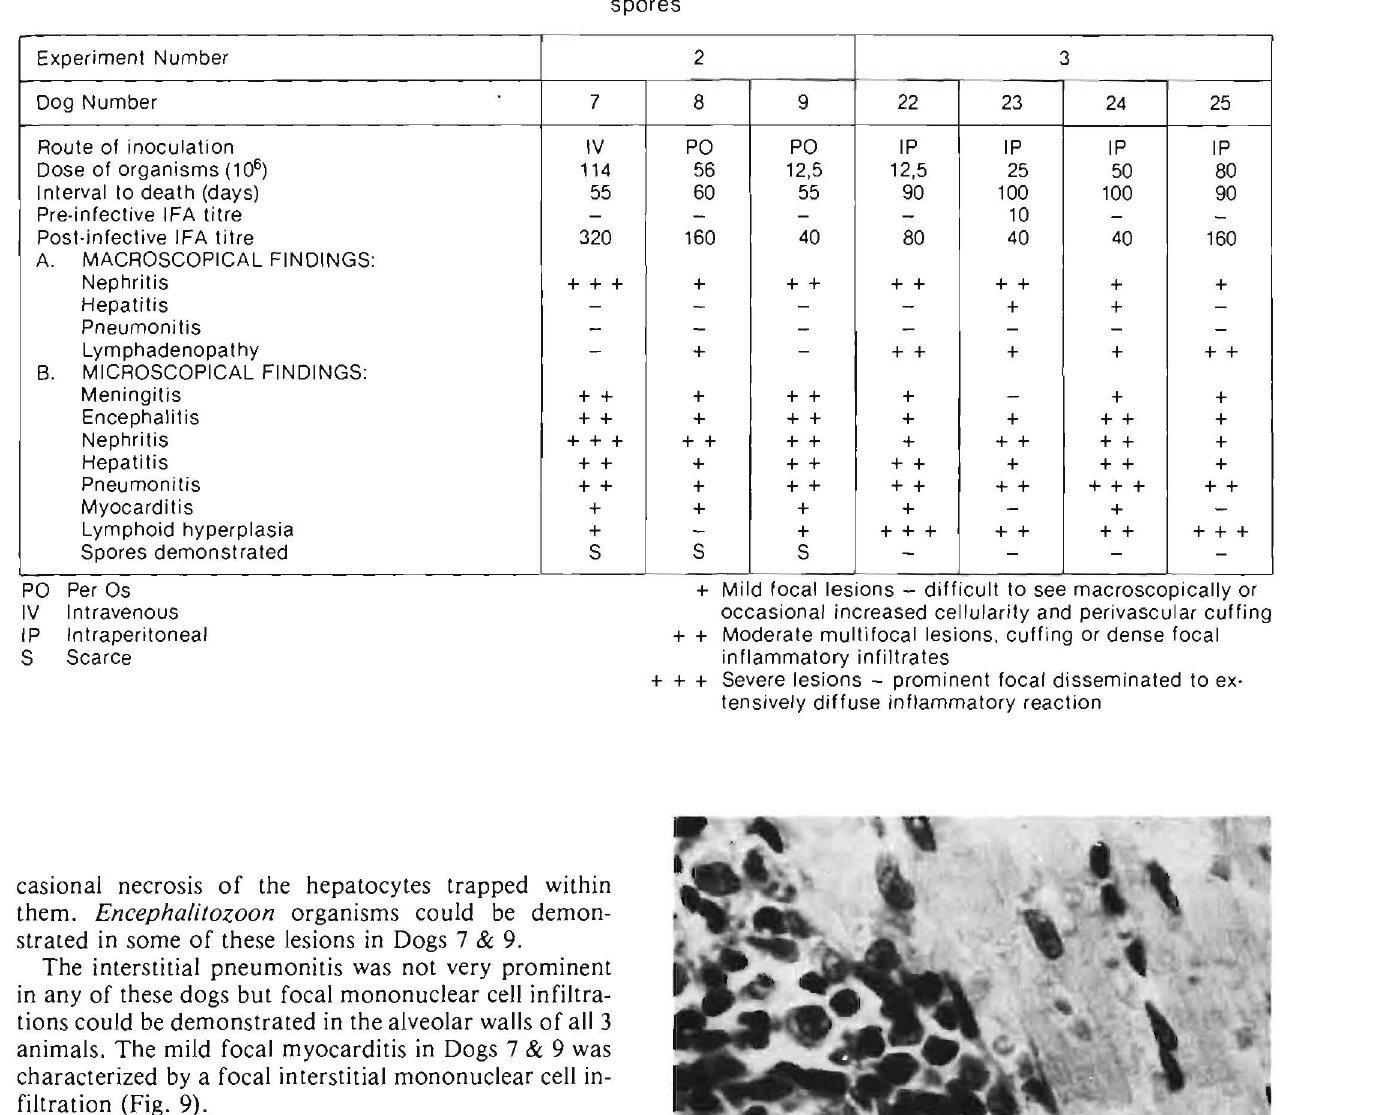
Table 3: Comparison of intravenous, per os and intraperitoneal infection by tissue culture-grown Encephalitozoon Experiment Number